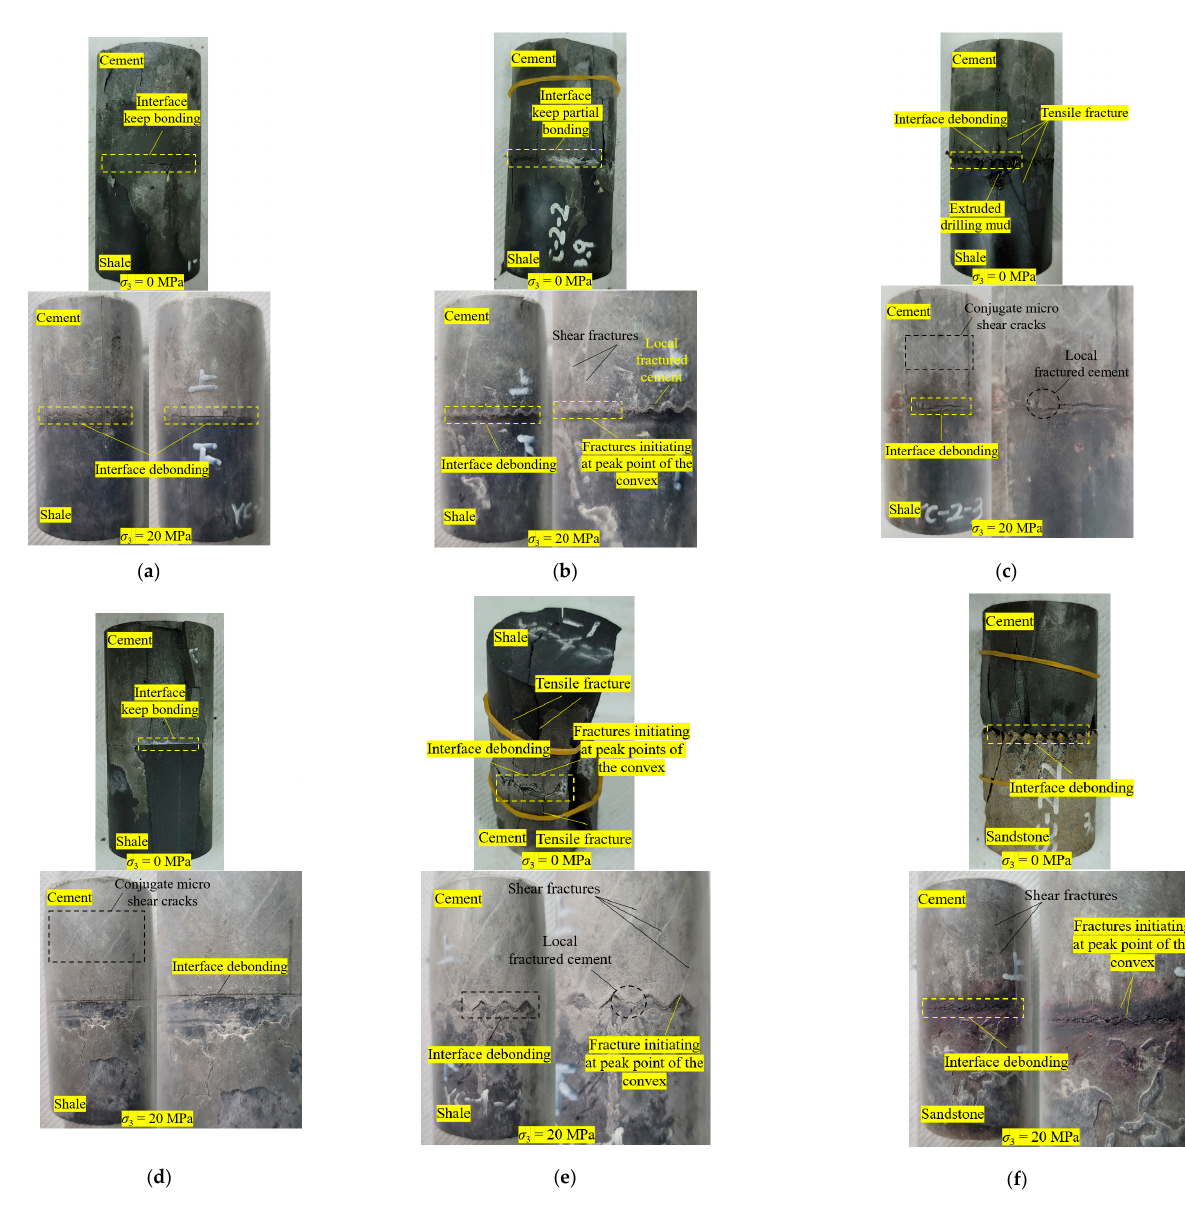
Figure 8. Deformation and failure characteristics of composite rock–cement specimens under uniaxial and triaxial compression. ( a ) YC-2-0-(1, 2), Roughness 1 mm, Fresh and untreated surface, ( b ) YC-2-2-(1, 2), Roughness 1 mm, Drilling mud contamination and flushing, ( c ) YC-2-3-(1, 2) Roughness 1 mm, Drilling mud contamination without flushing, ( d ) YC-0-2-(1, 2), Roughness 0 mm, Drilling mud contamination and flushing, ( e ) YC-4-2-(1, 2), Roughness 2 mm, Drilling mud contamination and flushing, ( f ) SC-2-2-(1, 2), Roughness 1 mm, Drilling mud contamination and